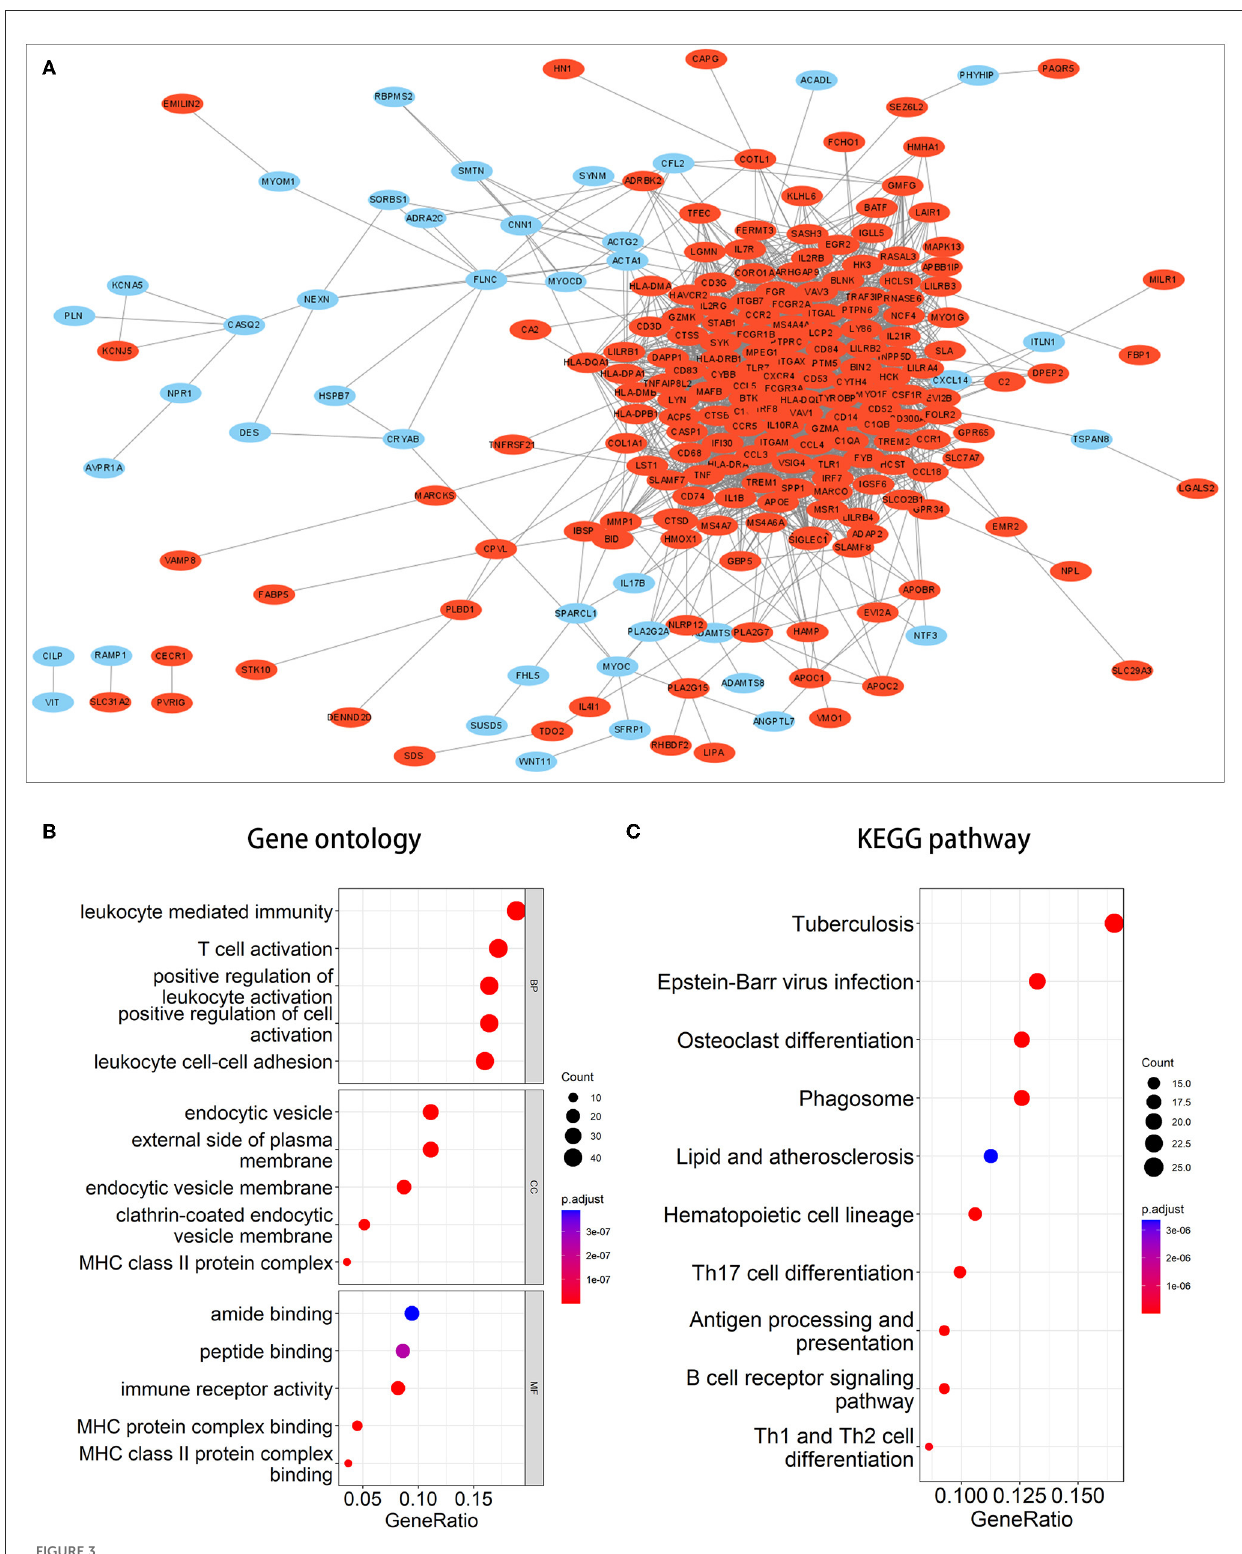
FIGURE3 PPI network and enrichment analysis of common DEGs. (A) PPI network of common DEGs. Red signifies upregulated genes, while blue denotes downregulated genes. (B, C) The outcomes of GO and KEGG pathway enrichment analyses. It was deemed significant if the adjusted P -value of <